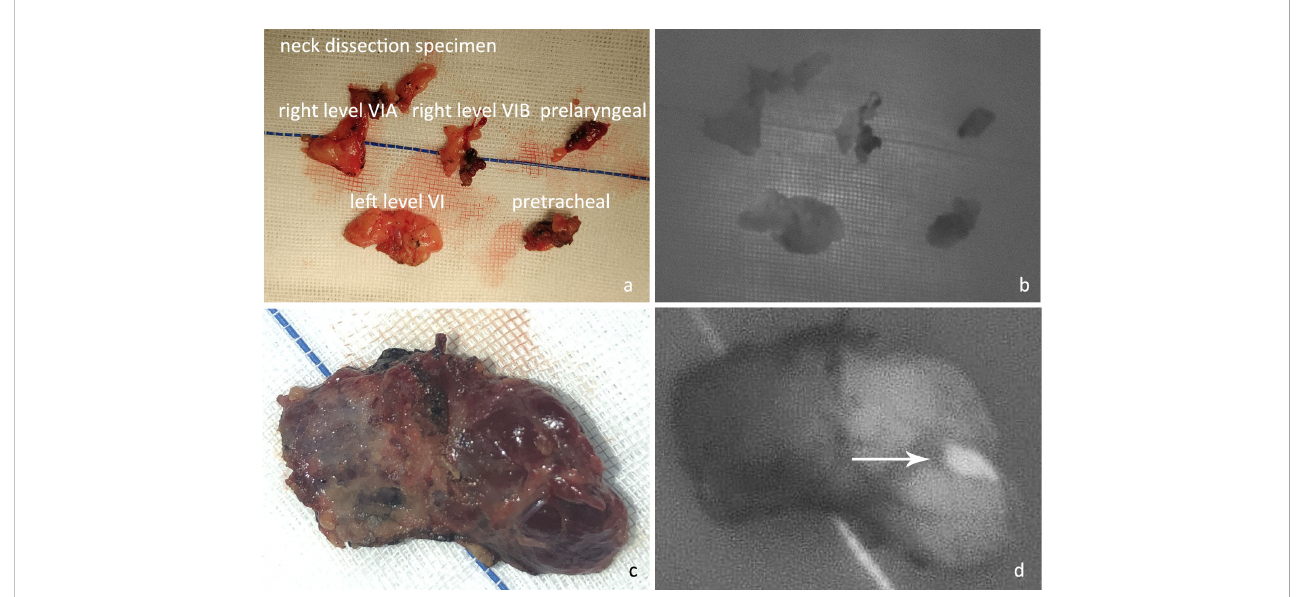
FIGURE 6 (A) After en bloc resection, the neck dissection specimen was examined in different regions. (B) The NIRAF revealed that no parathyroid gland had been accidentally resected. (C) Examination of excised thyroid specimens. (D) The isolated left superior parathyroid gland (white arrow) was found on examination of the thyroid specimen. (These two images were from a case not included in this controlled